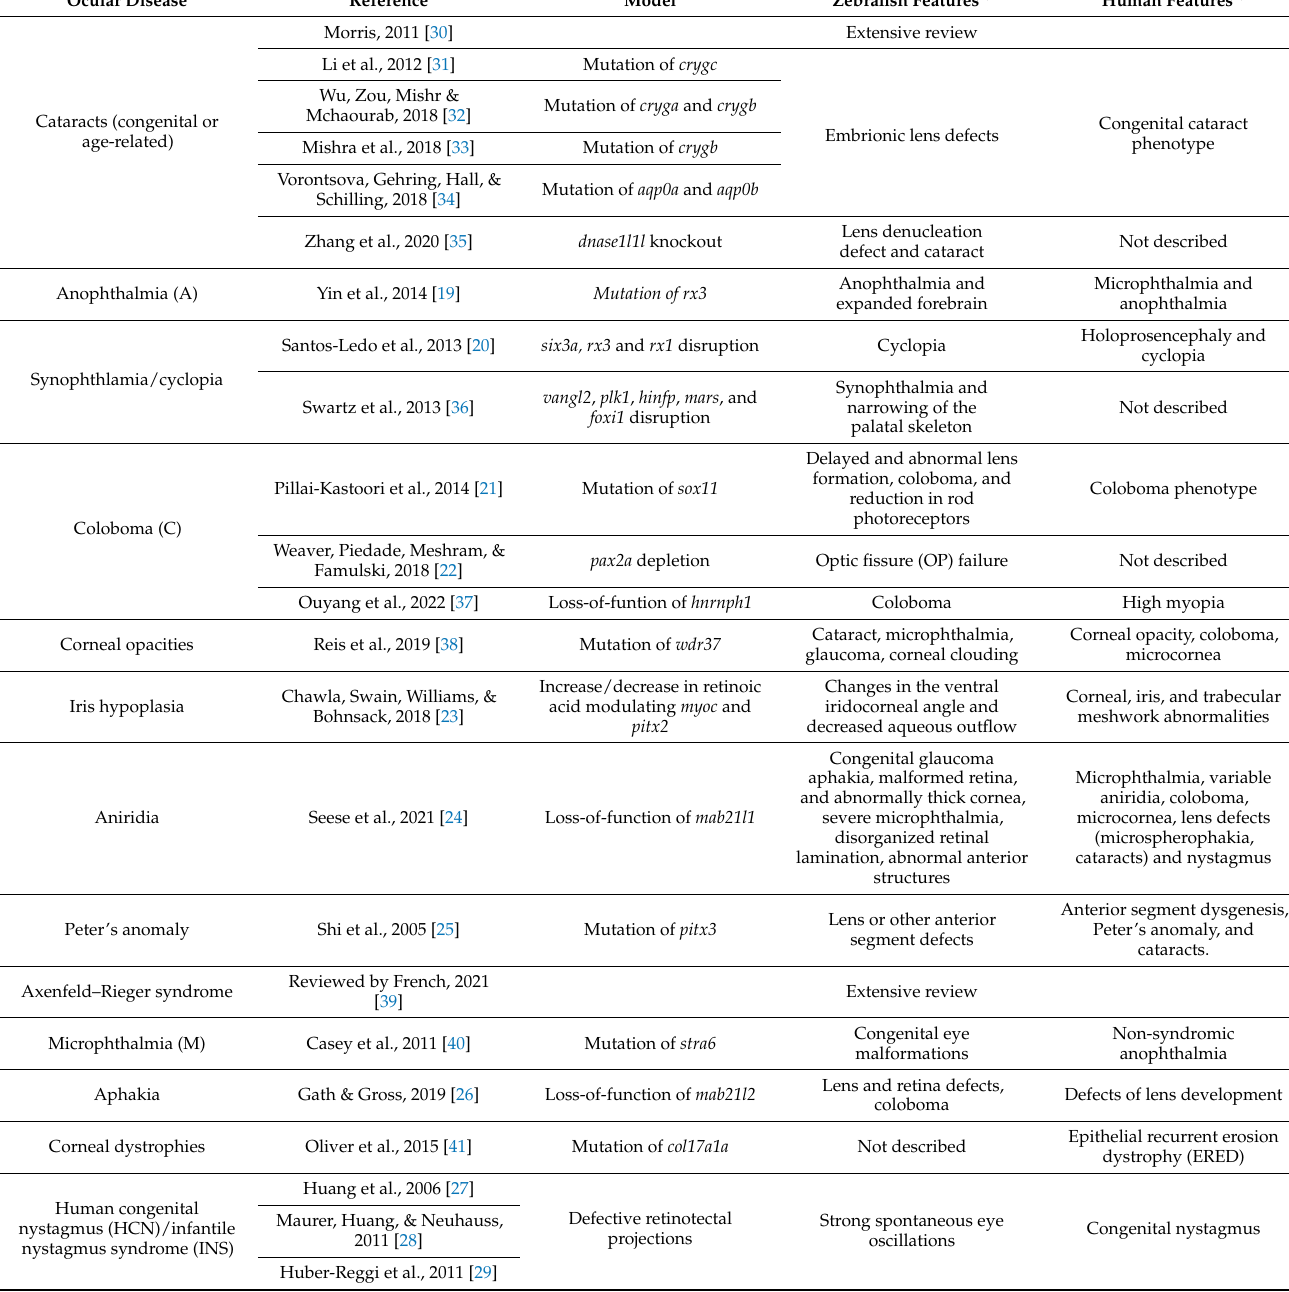
Table 1. Defects of the Anterior